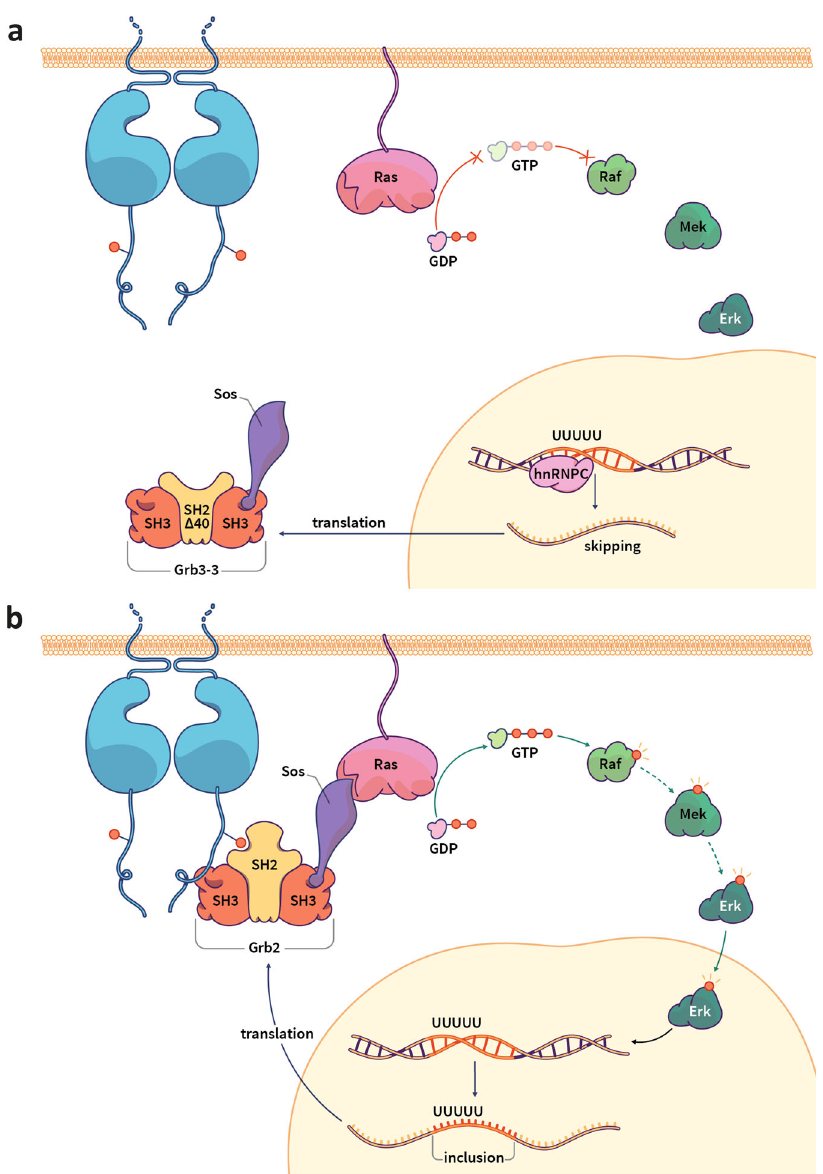
Fig. 5 Model for molecular mechanism for the control of RAS activation by Grb3-3. a In Grb3-3 expressing cells, hnRNPC binds to the pentameric poly uracil sequence in GRB2 exon 4, resulting in the skipping of exon 4 leading to the production of Grb3-3. Grb3-3 binds to the proline-rich C-terminus of Sos and inhibits Grb2 binding to phosphorylated sites (red dots) on tyrosine residues of activated RTKs and concomitant membrane recruitment. Sos remains in the cytoplasm which prevents RAS activation. This ultimately limits ERK translocation to the nucleus and hence cell proliferation. b In tumour cells, hnRNPC expression is down-regulated, therefore exon 4 is included producing Grb2. Grb2 binds to Sos and to activated RTKs at the cell surface bringing Sos into close proximity of its substrate RAS. Sos activates downstream signalling via RAS. This results in ERK translocation to the nucleus and transcription of multiple gene leading to cell